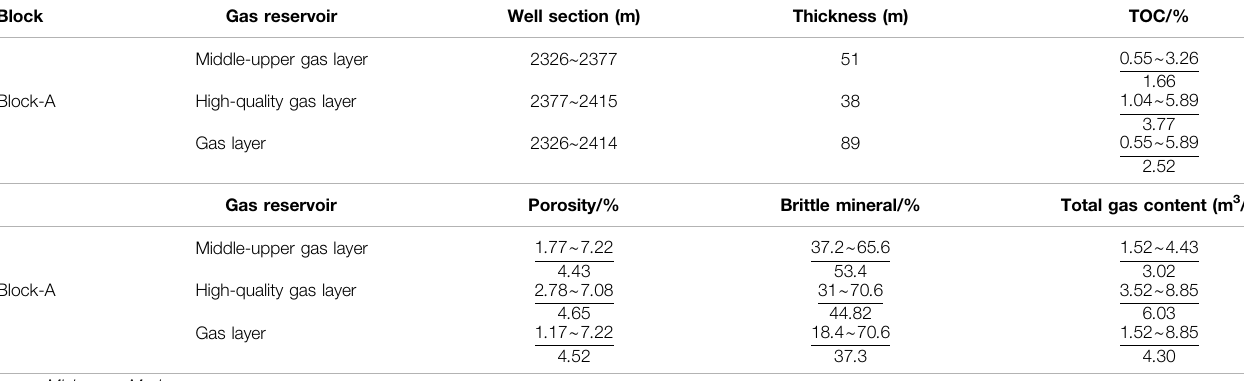
TABLE 1 | Table of A shale gas evaluation parameters in Longtan formation. Block